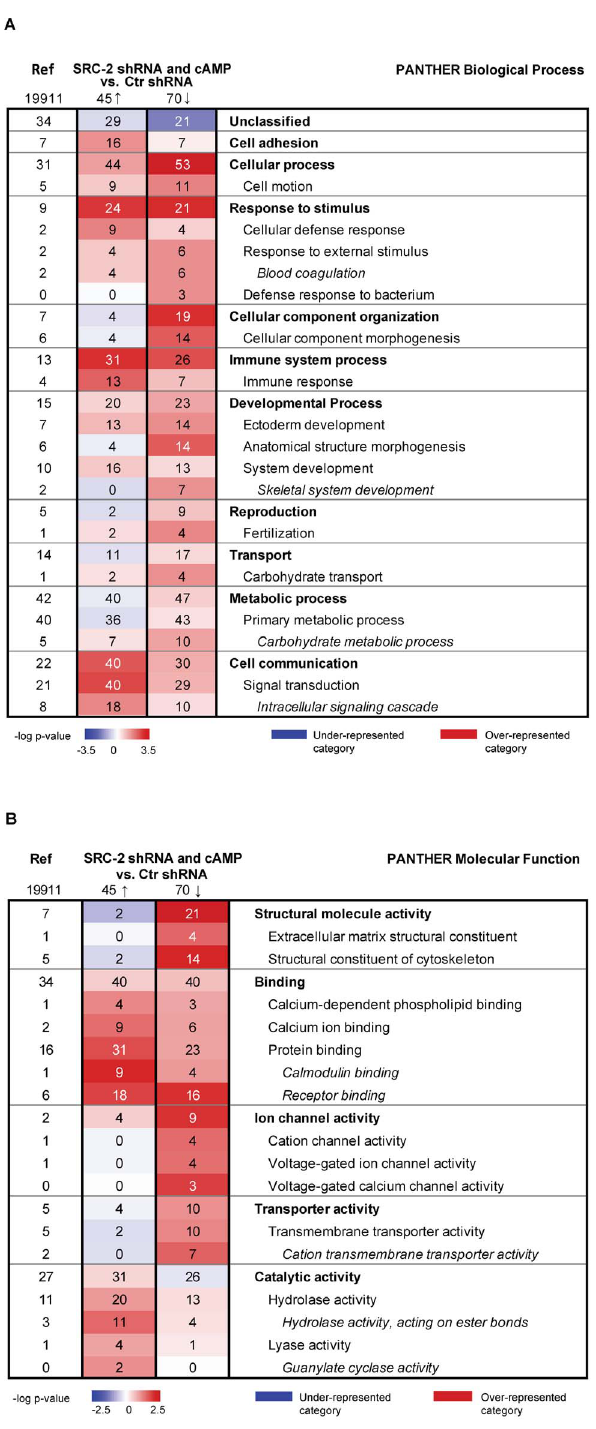
Figure 2. Functional categorization of differentially expressed overlapping genes. PANTHER was used to search for over-represented Biological Process categories (A) and Molecular Function categories (B) among the differentially expressed overlapping up-regulated genes after SRC-2 KD (SRC-2 shRNA) and after exposure of cAMP elevating agents, and among the differentially expressed overlapping downregulated genes from the same two samples (fold change $ 1.3, q-value=0). Bonferroni correction for multiple testing was performed and a p-value of 0.05